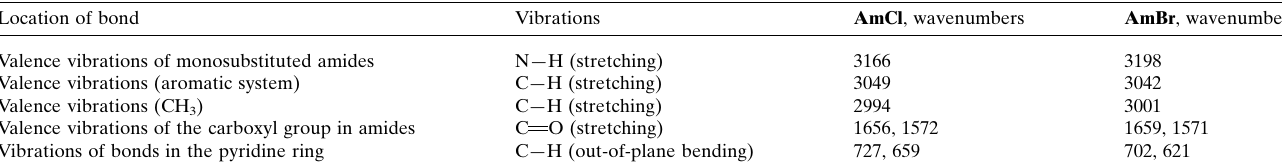
Table 3 Characteristic vibration frequencies according to the FTIR